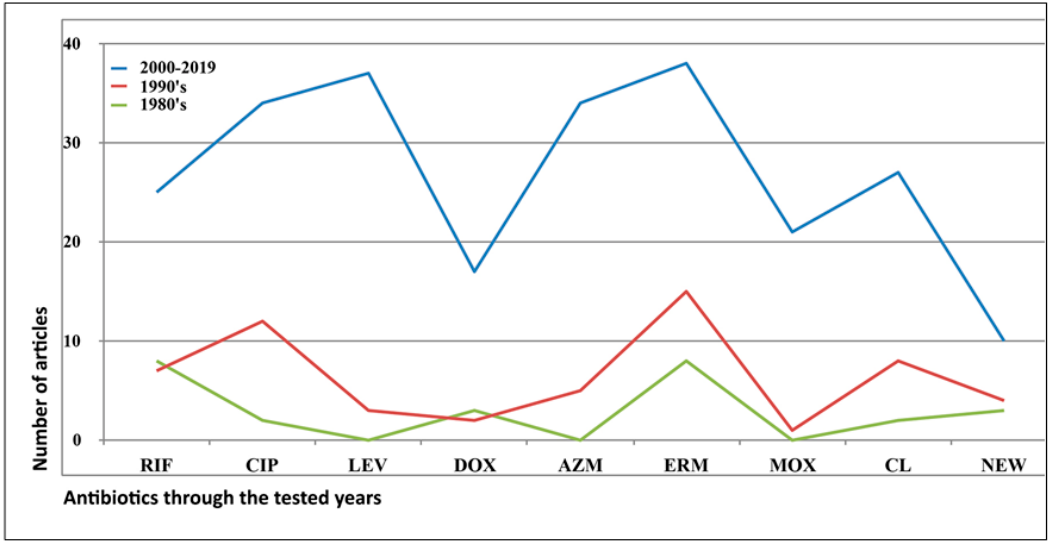
Figure 2. The use of antibiotics during the studied decades, 1980–2019. On the y axis, the number of articles in which each antibiotic has been mentioned is presented. Abbreviations: RIF, rifampicin; CIP, ciprofloxacin, LEV, levofloxacin; DOX, doxycycline; AZM, azithromycin; ERM, erythromycin; MOX, moxifloxacin; CL, clarithromycin; NEW, antimicrobial agents such as LBM415 and TP-271 (Table S1 raw data).